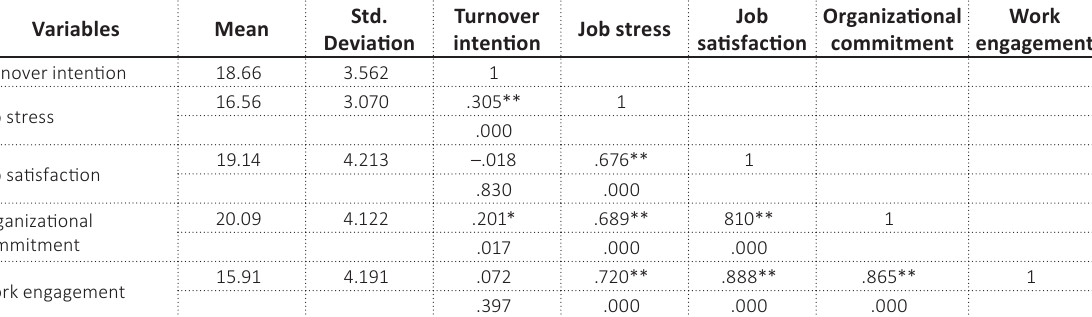
Table 4. Correlations of variables